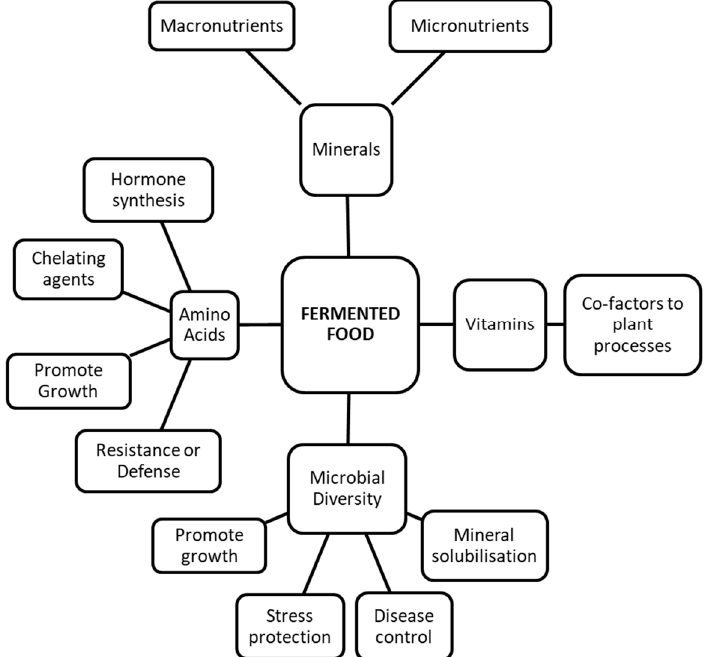
Figure 1. Possible mechanisms of plant-promoting features of fermented food. Fermented foods contain a rich amount of free amino acids [42], vitamins [43], minerals [44], and microorganisms [45] that are essential for plant growth.